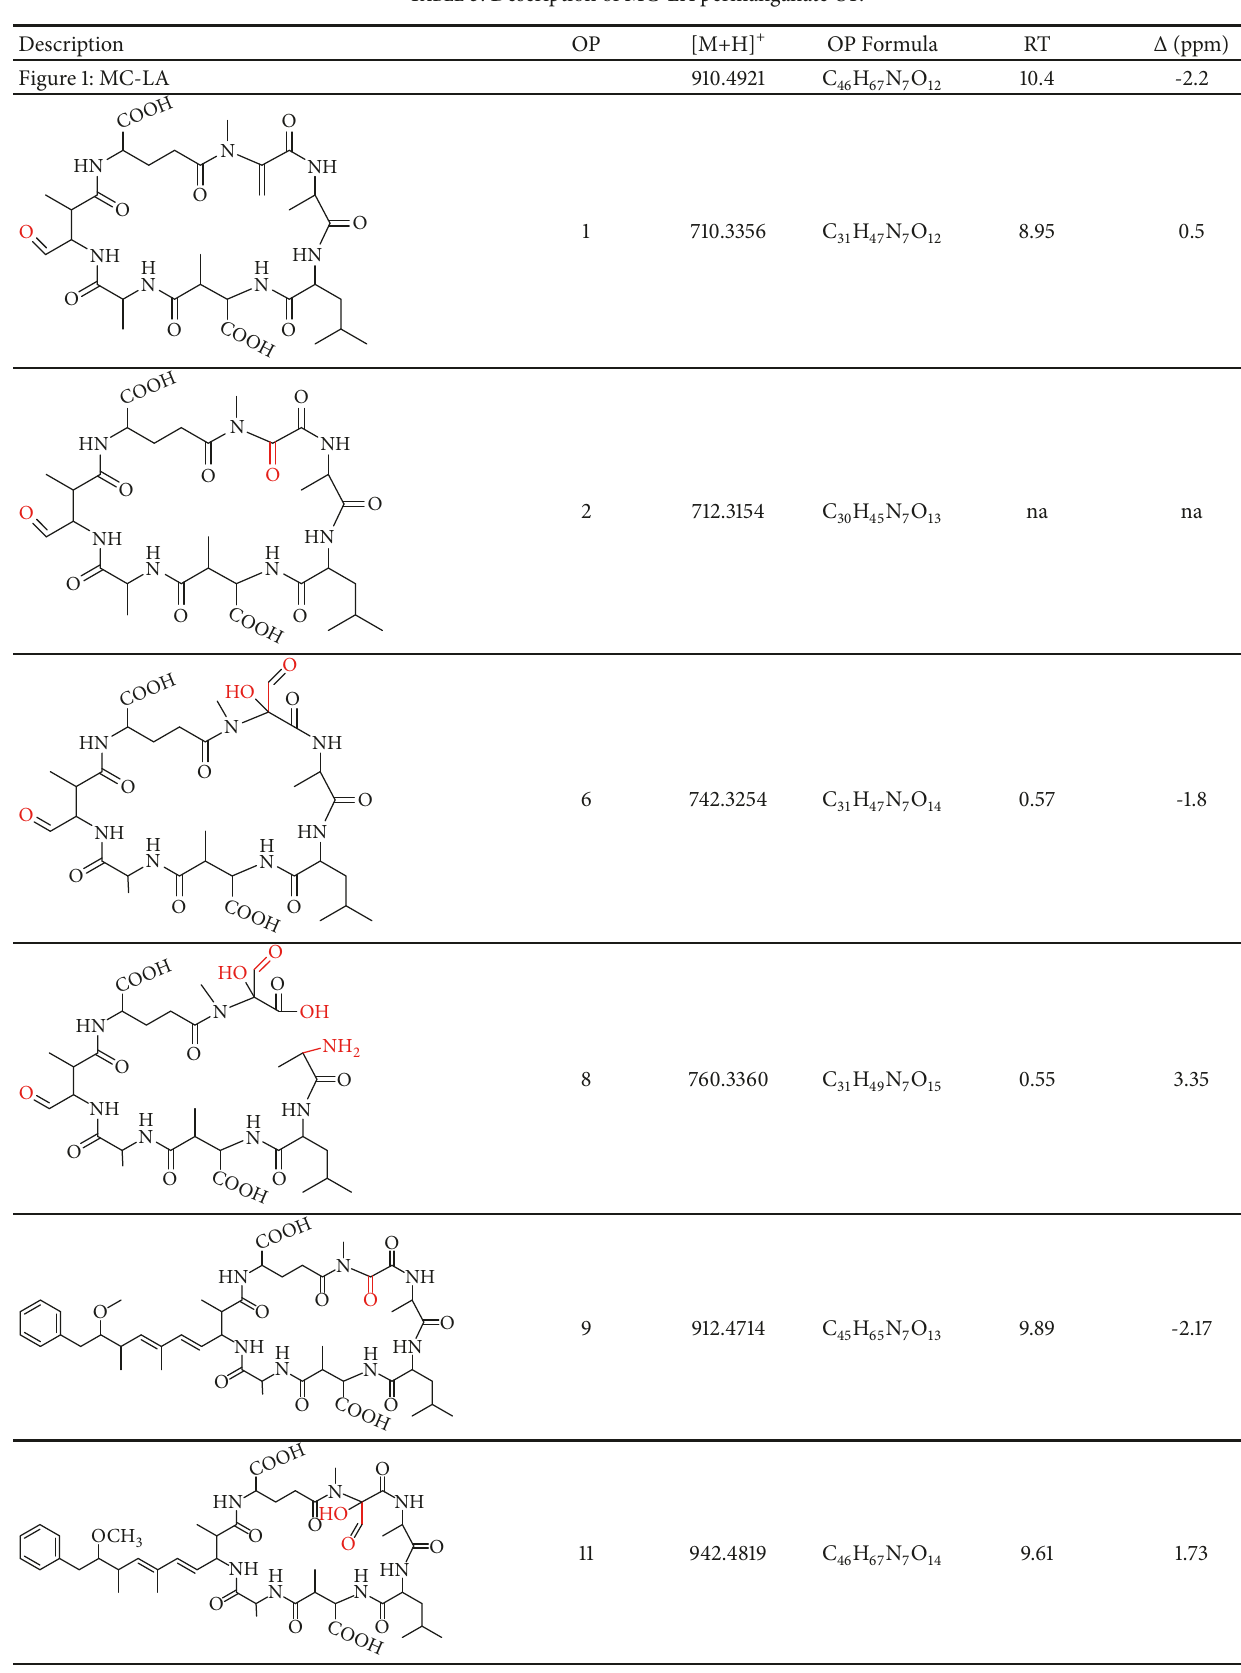
Table 5: Description of MC-LA permanganate OP.